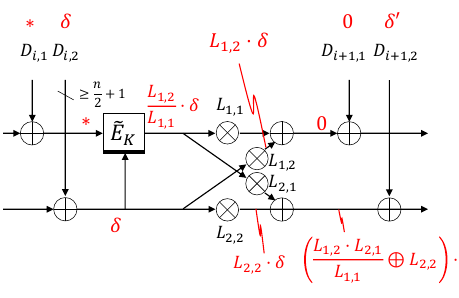
Figure 7: Attack against Case 2 where all of L 1 , 3 , L 1 , 4 , L 2 , 3 and L 2 , 4 are non-zero.